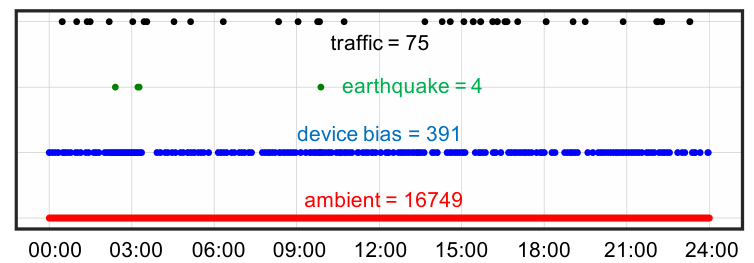
Figure 19. In-device prediction (classification) of measured field vibration data for 24